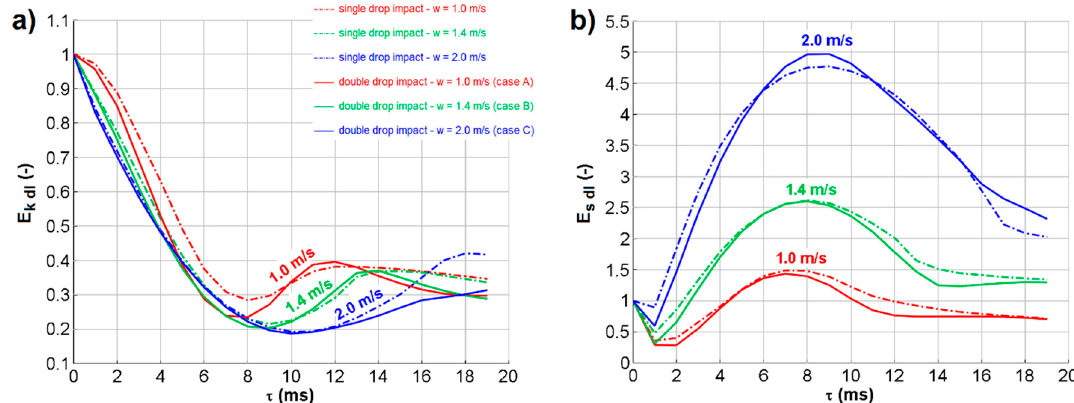
Figure 8. Time evolution of the normalized kinetic energy ( a ) and normalized surface energy ( b ) in the domain after double drop impact, as a function of time for single (dash-dot lines) and double (continuous lines) drop impacts.